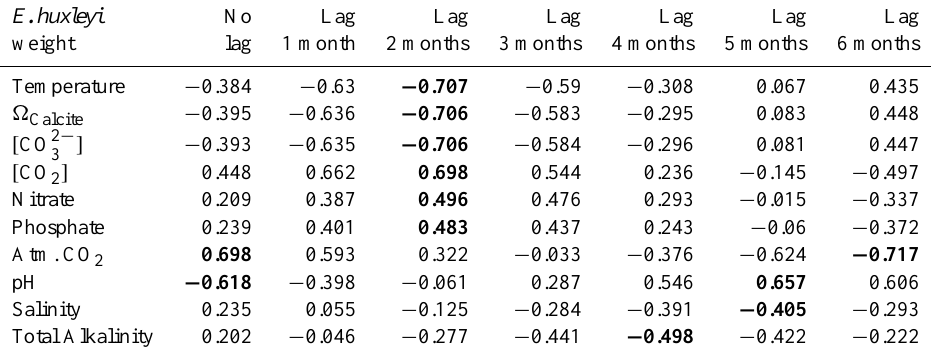
Table 2. Cross-correlation between the seasonal signals extracted by an SSA analysis from E. huxleyi coccolith weight and time-series parameters, calculated for lags of 0 to 6 months. Maximum correlations are set in